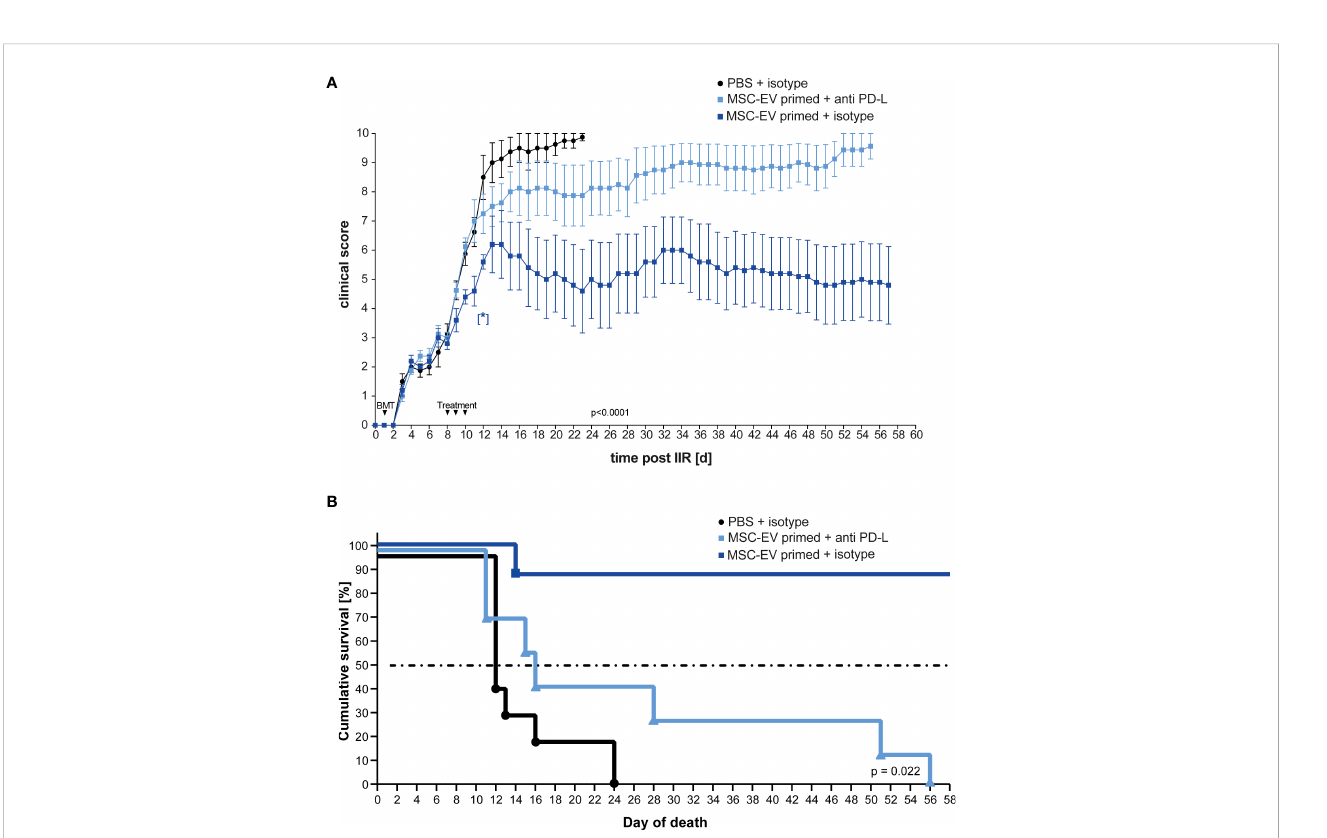
FIGURE 5 Inhibition of PD-Ligands on primed MSC-EVs abrogates bene fi cial therapeutic effects. Balb/c mice were lethally irradiated (day 0) and injected with CD90.2 depleted bone marrow cells and naïve CD4 cells from C57BL/6J mice to induce GvHD (day 1) and treated with MSC-EVs of unstimulated MSCs or TNF a , IFN g and IL-1 b stimulated MSCs at day 8, 9 and 10 with primed MSC-EVs pre-incubated with inhibitory PD-1 ligand antibodies or isotype control. (A) Time fl owchart of clinical score. Data is shown as center value: mean; error bars: SEM. P value indicates statistical differences between the groups until day 24, analysed by linear regression. [*] Indicates p=0,026 signi fi cant difference between triple-primed+isotype MSC-EV treated and PBS +isotype treated group two days after last treatment on day 12. (B) Kaplan Meier survival curve. n = 8; MSC-EV stimulated + anti-PD-L antibody n = 8; MSC-EV stimulated + isotype control, n = 5. P-value indicates statistical difference for survival between treatment groups, Gehan-Breslow-Wilcoxon test was used to test statistical signi fi cance.